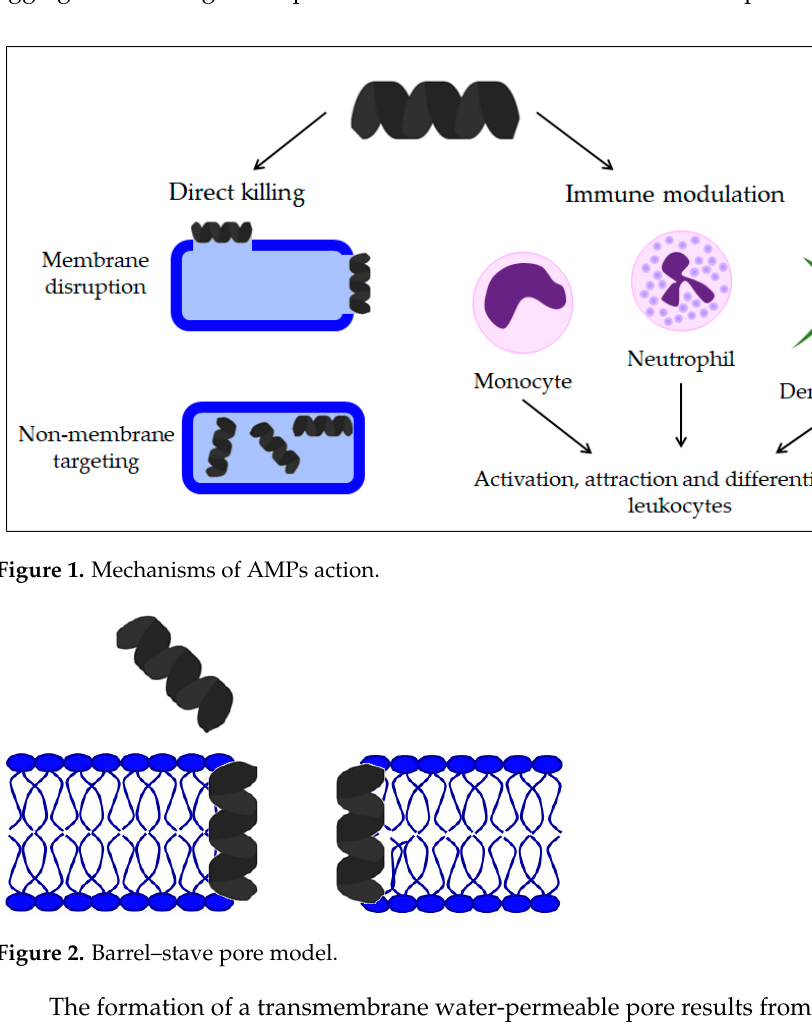
Figure 2. Barrel–stave pore model.